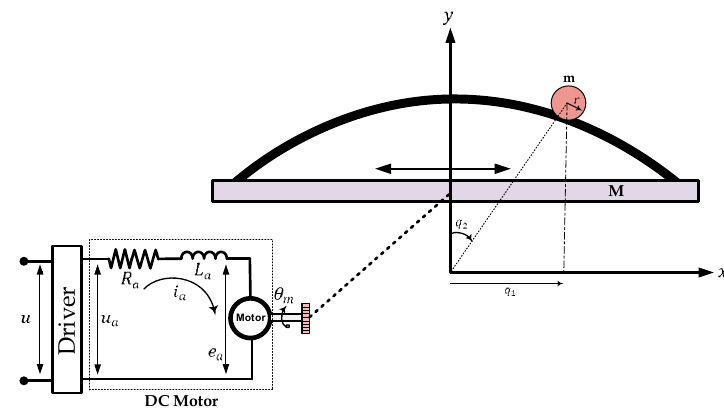
Figure 1. Schematic representation of the ball–arc system.